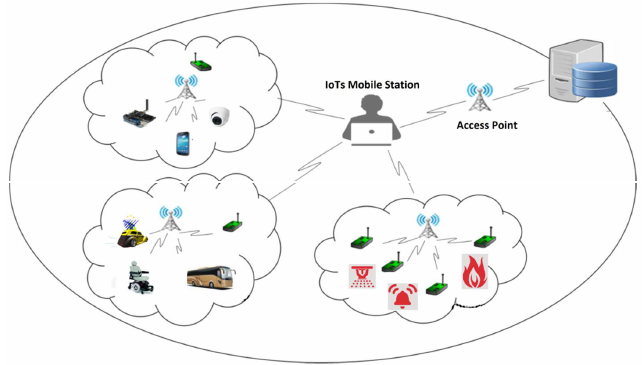
Figure 1. A general picture of IoT applications in the real